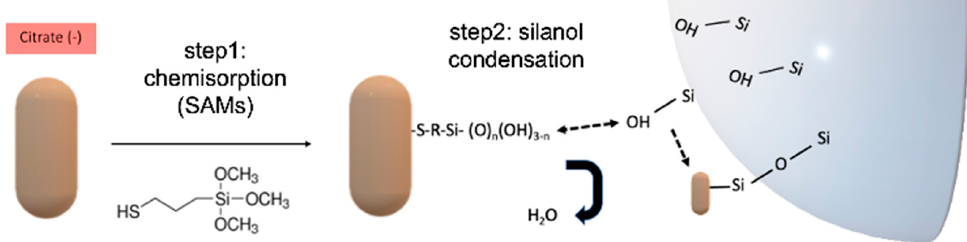
Figure 1. Sequential modification of citrate stabilized Au-NR using a two-step procedure. Step 1, Au-S chemisorption on the PNPs; Step 2, condensation reactions between silanol moieties present on the microresonator surface and MPTMS (3-mercaptopropyl-trimethoxysilane)-modified Au-NR (Au-NR@HS-Si(OH) n ).